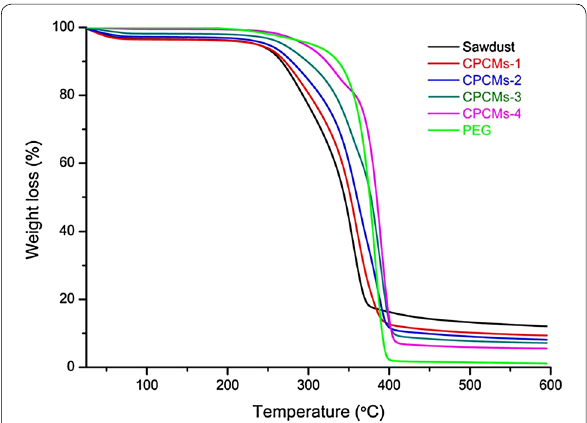
Fig. 12 The TG curves of waste sawdust, CPCMs‑1‑4, and